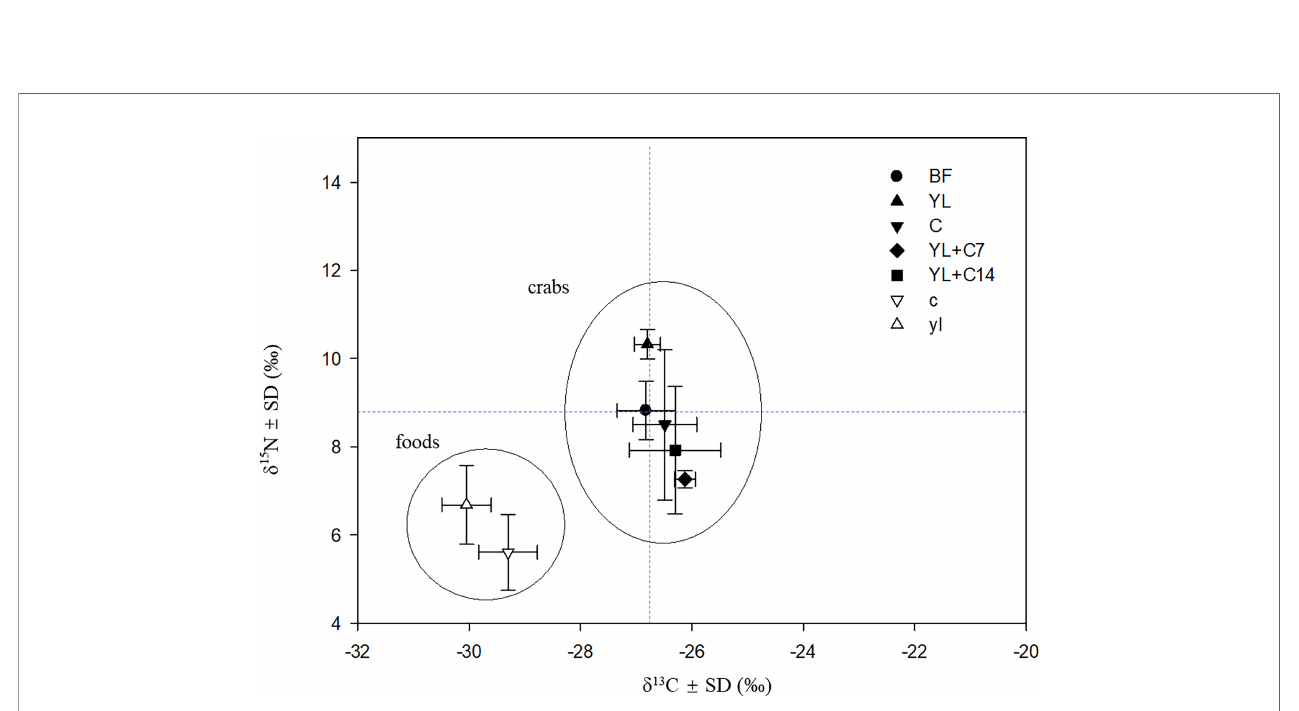
FIGURE 5 | d 13 C and d 15 N plot of food sources and N. smithi before and after feeding for 60 days on different food items. BF, before feeding experiment (just after collection from the fi eld); YL, fed yellow leaves; C, fed calyx; YL+C7, fed yellow leaves and supplemented with calyx every 7 days; YL+C14, fed yellow leaves and supplemented with calyx every 14 days; yl, yellow leaves; c,